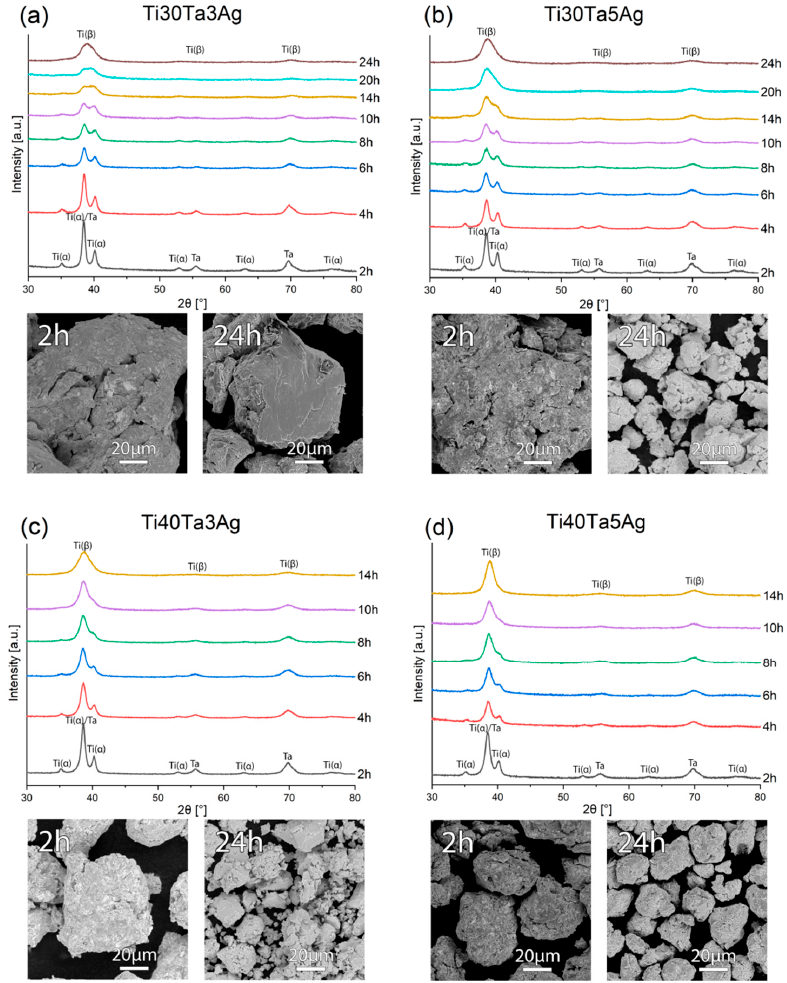
Figure 1. The XRD spectra and SEM micrographs of the ( a ) Ti30Ta3Ag, ( b ) Ti30Ta5Ag, ( c ) Ti40Ta3Ag, and ( d ) Ti40Ta5Ag powders at various milling